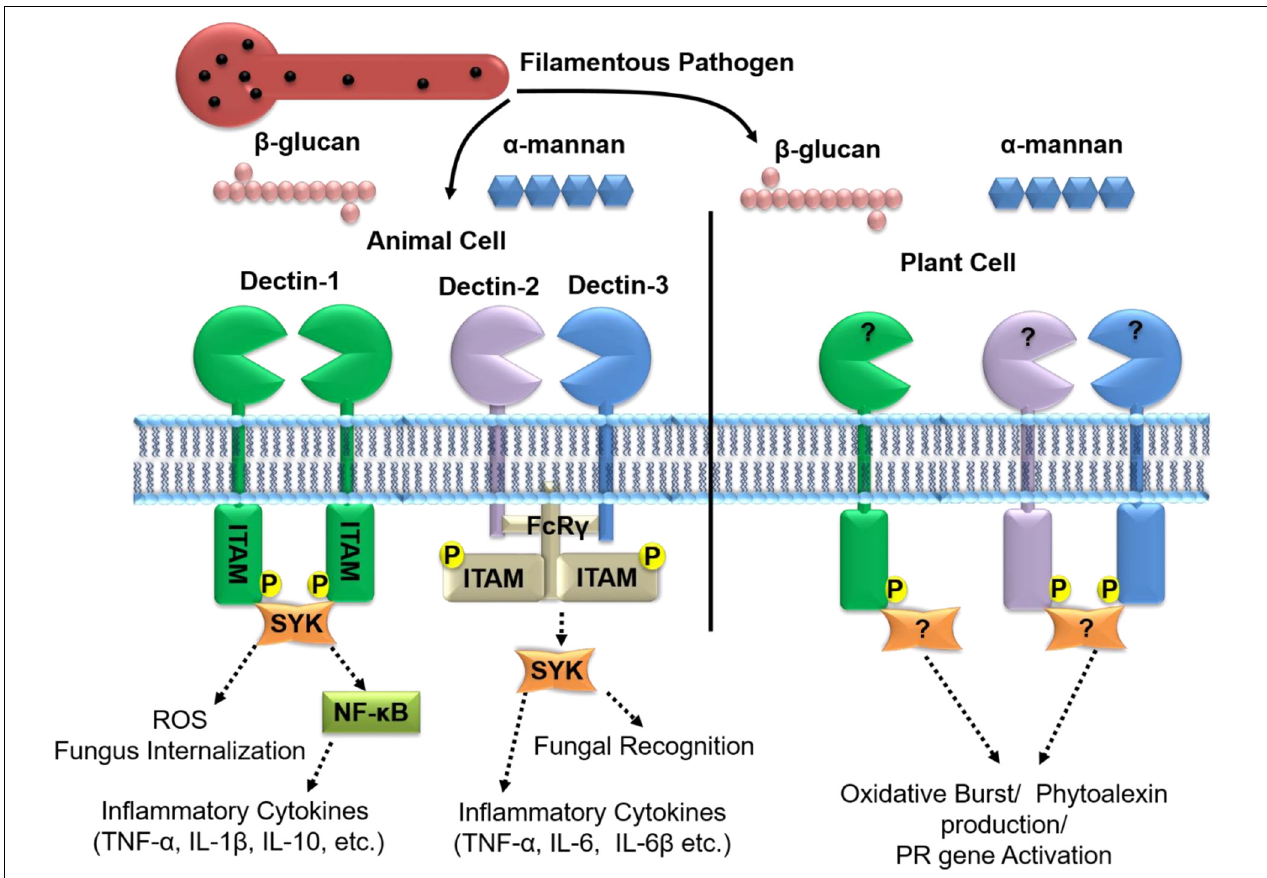
FIGURE 6 | β -glucan and α -mannan mediated signaling in animal cells alongside the putative system in plants. In animal cells, the recognition of β -glucan is mediated through Dectin-1 homo-dimerization followed by the phosphorylation of its cytoplasmic Immuno-receptor Tyrosine-Based Activation (ITAM) domain and downstream cell signaling. Activation of Dectin-1 signaling can lead to stimulation of ROS pathways, internalization of pathogen by cells and activation of chemokine/cytokines/caspases. α mannans on the other hand are recognized by the hetero-dimerization of Dectin-2 and Dectin-3 followed by the phosphorylation of the FcR γ -ITAM motifs and downstream signaling that triggers the production of pro-inflammatory cytokines (TNF- α , IL10, IL12, and IL-6, etc.). Although little is known about β -glucan perception in plants, studies suggest β -glucan treatment leads to the defense responses that include generation of H 2 O 2 , production of phytoalexins and activation of PR-genes. It is not clearly known if homologs of Dectin-1/2/3 are functional in the recognition and defense signaling in responses to the filamentous pathogens of plants. The dotted lines represent the signaling pathways